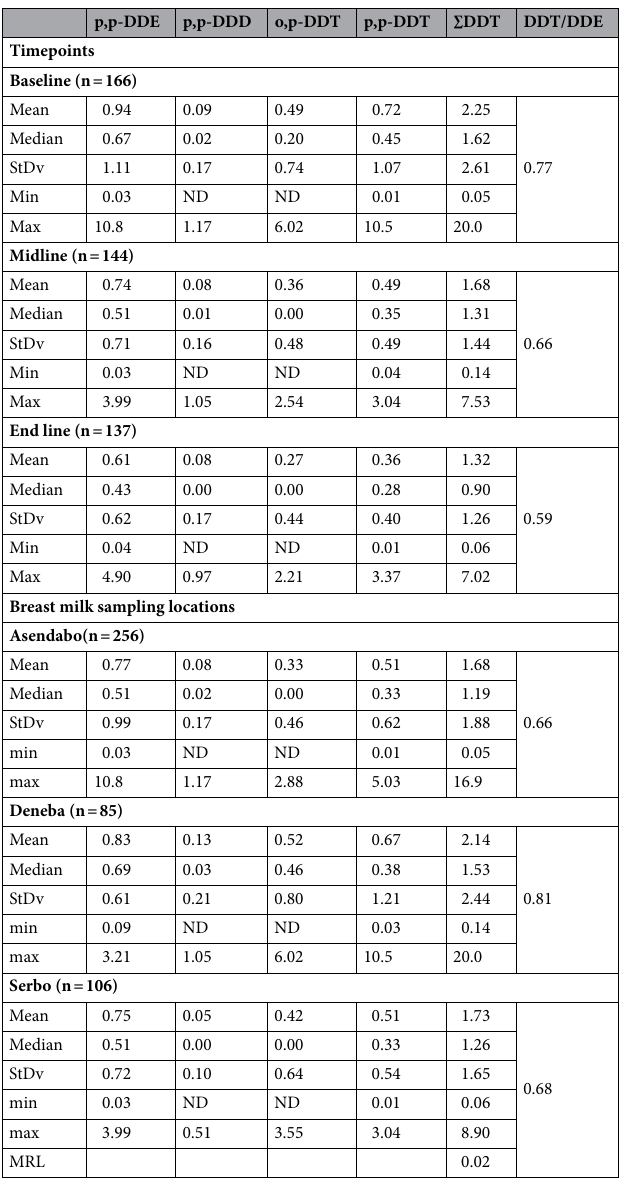
Table 1. Summary statistics of DDT and its metabolite concentration (µg/g milk fat) in breast milk by sampling time points, location, and a lifetime of DDT application(DDT/DDE). ND = Not Detected, MRL = Maximum Residue